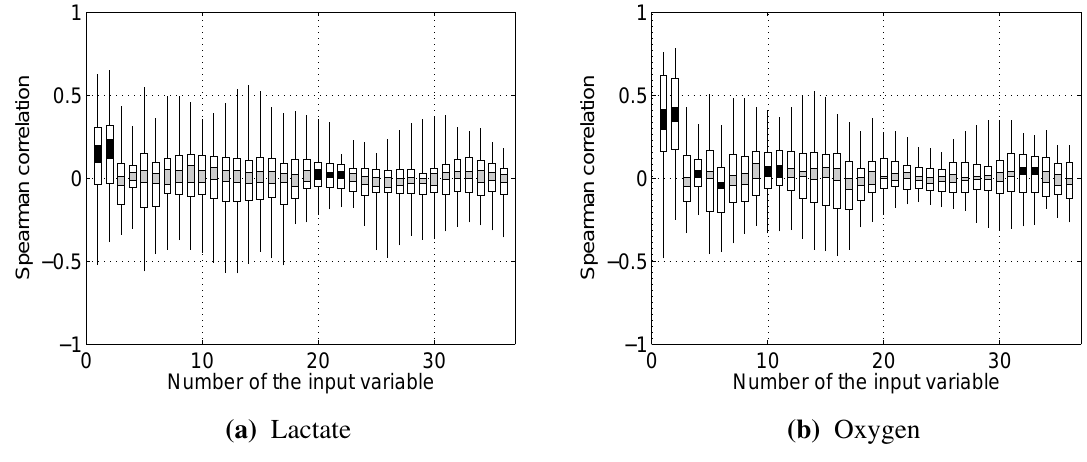
Figure 4. Spearman correlations between the input variables and physiological indicators. Black bars indicate average correlation significantly different from zero (Student’s t -test, p < 0 . 05 ). Every segment corresponds to 0.2 quantiles. Variables and their numbers were defined in Section 2.5.